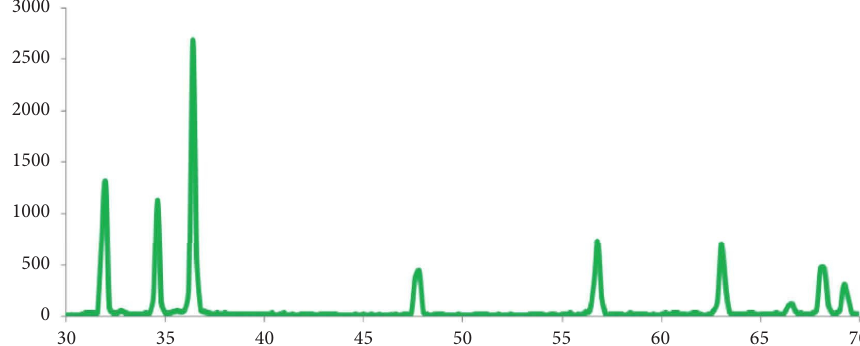
Figure 1: X-ray difraction (XRD) pattern of synthesized G-ZnO NPs via the sol-gel process.